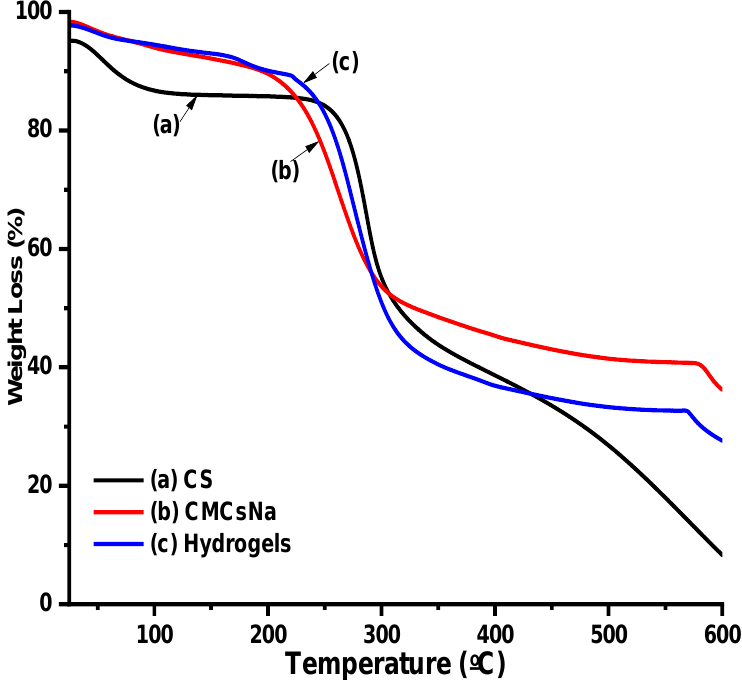
Figure 6. TGA thermograms of (a) Cs, (b) CMCsNa, and (c) hydrogels.